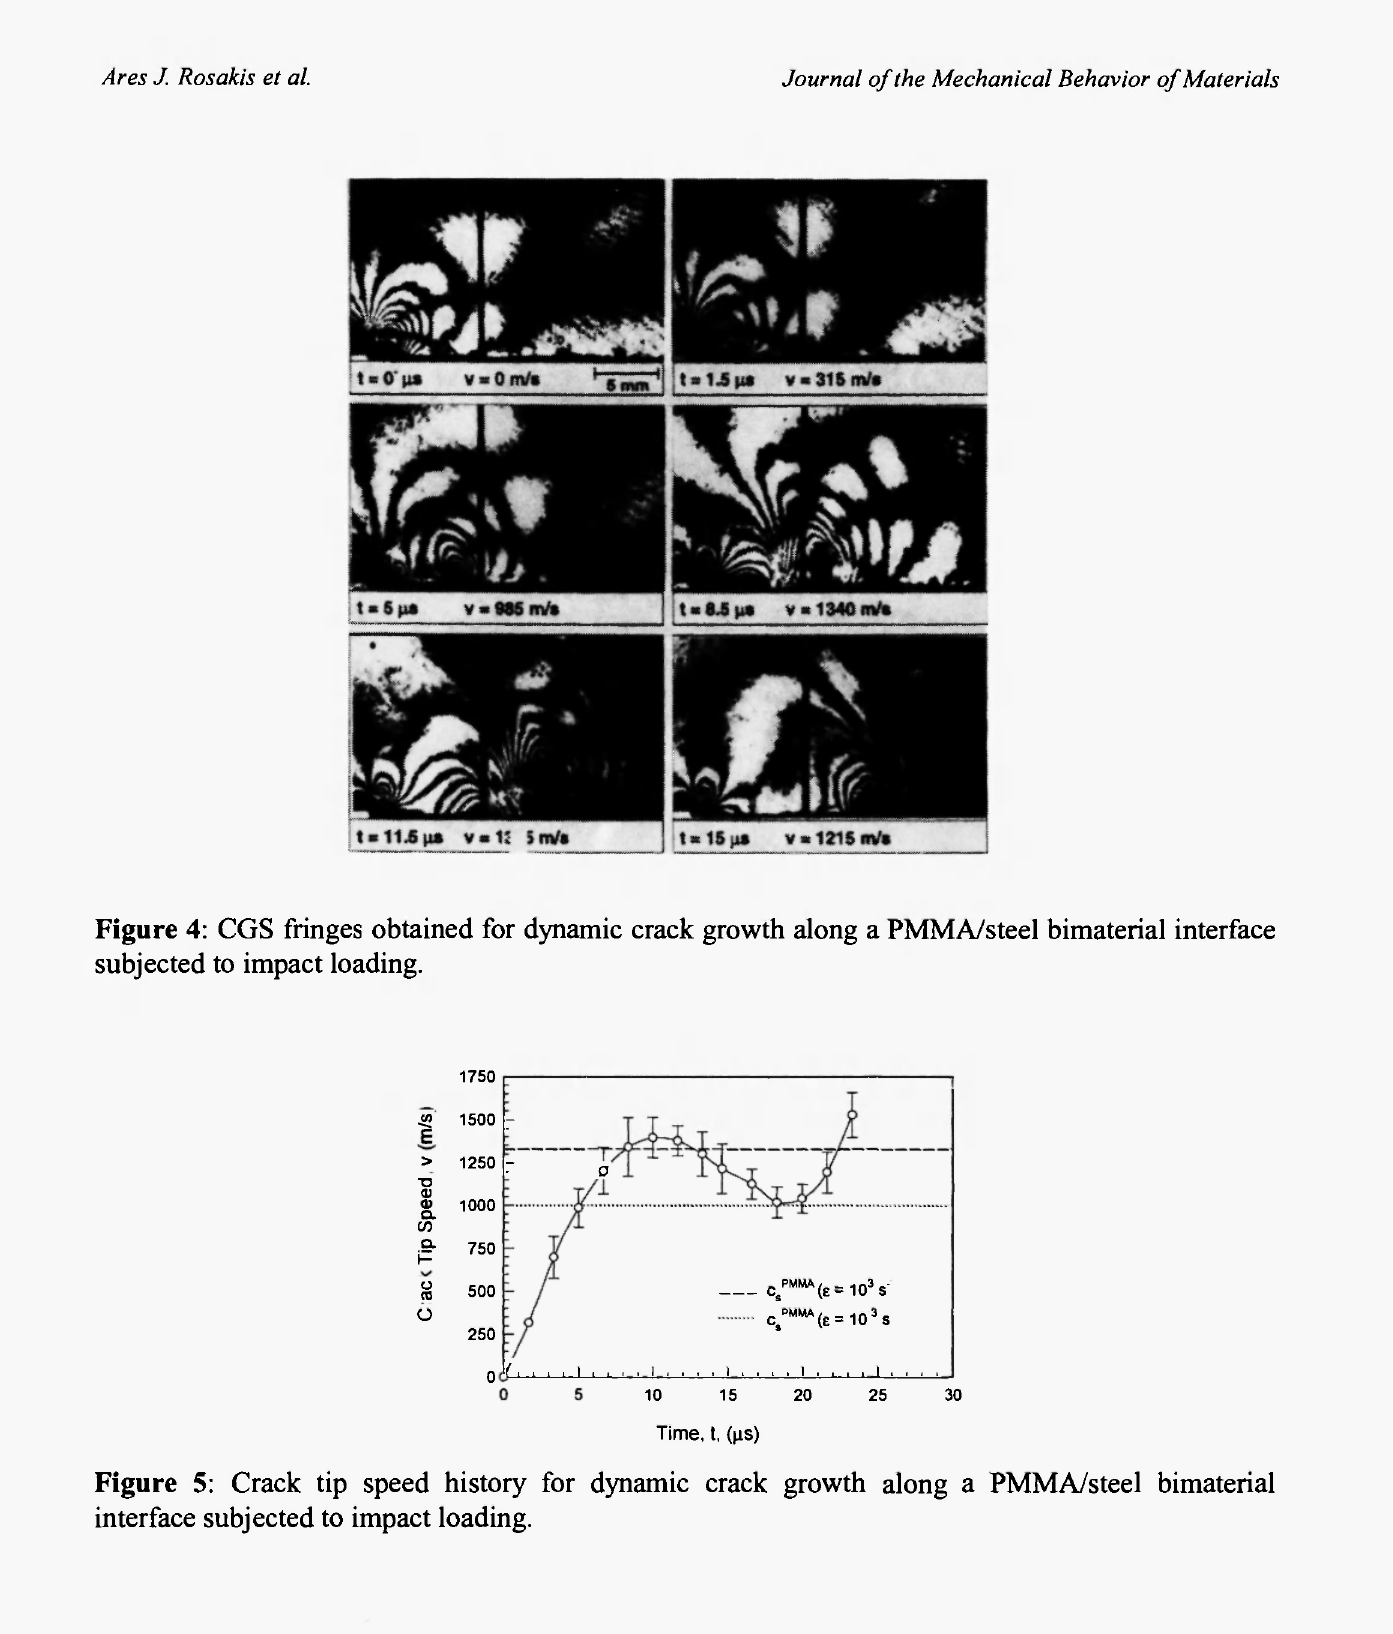
Figure 5: Crack tip speed history for dynamic crack growth along a PMMA/steel bimaterial interface subjected to impact